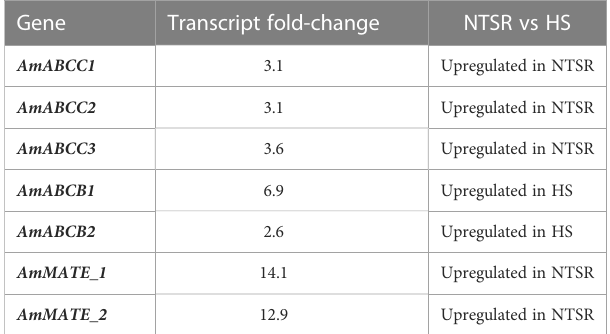
TABLE 1 Identi fi cation of contigs encoding ABC and MATE transporter proteins in the global transcriptomes of non-target site resistance (NTSR) and herbicide sensitive (HS) blackgrass ( Te ́ tard- Jones et al.,